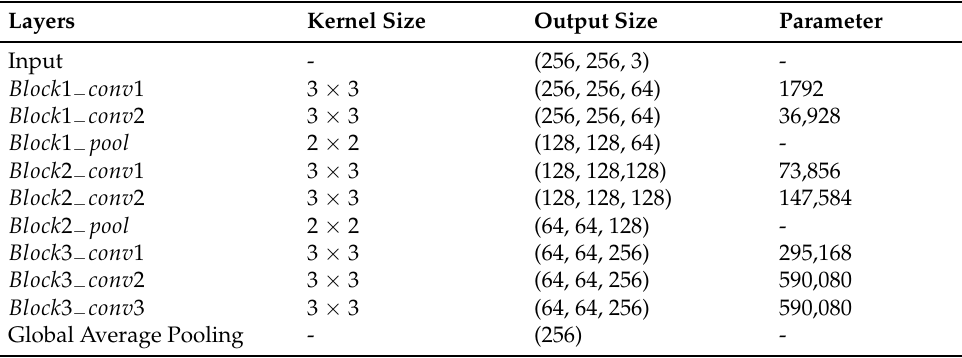
Table 2. Related parameter and output size of shallow VGG